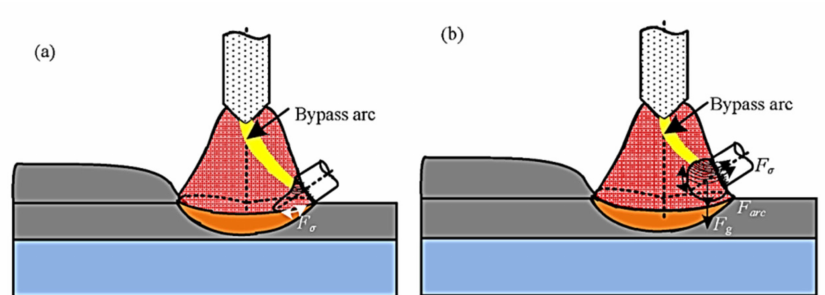
Figure 11. Schematic of force distribution on the droplet: ( a ) Bridging Transfer; ( b ) force transfer. Reprinted from Ref.